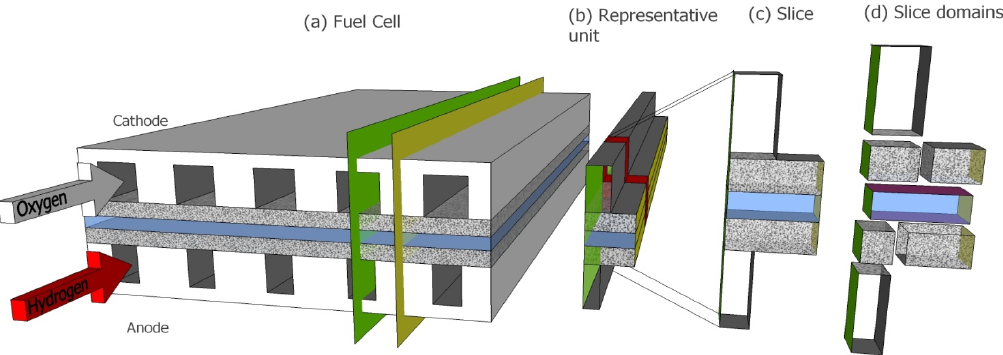
Figure 1. Schematic breakdown of fuel cell geometry onto elementary units for HAN-FC computation. The blue and the spotted translucent regions represent the membrane and GDL respectively, the green surfaces represent the plane of symmetry across the middle of a rib and the yellow surfaces the plane of symmetry between two ribs. ( a ) A five-rib parallel channel co-flow fuel cell geometry. The two symmetry planes that apply to all ribs are shown on one half of rib defining the representative unit; ( b ) Representative unit with indicated slice (red); ( c ) Slice as a sliced-out section of the representative unit that has sufficiently small depth to be treated as a 2D object and ( d ) Slice domains from top to bottom: cathode channel domain, cathode GDL domains (left cathode GDL#1, right cathode GDL#2), MEA domain, anode GDL domains (left anode GDL#1, right anode GDL#2), anode channel